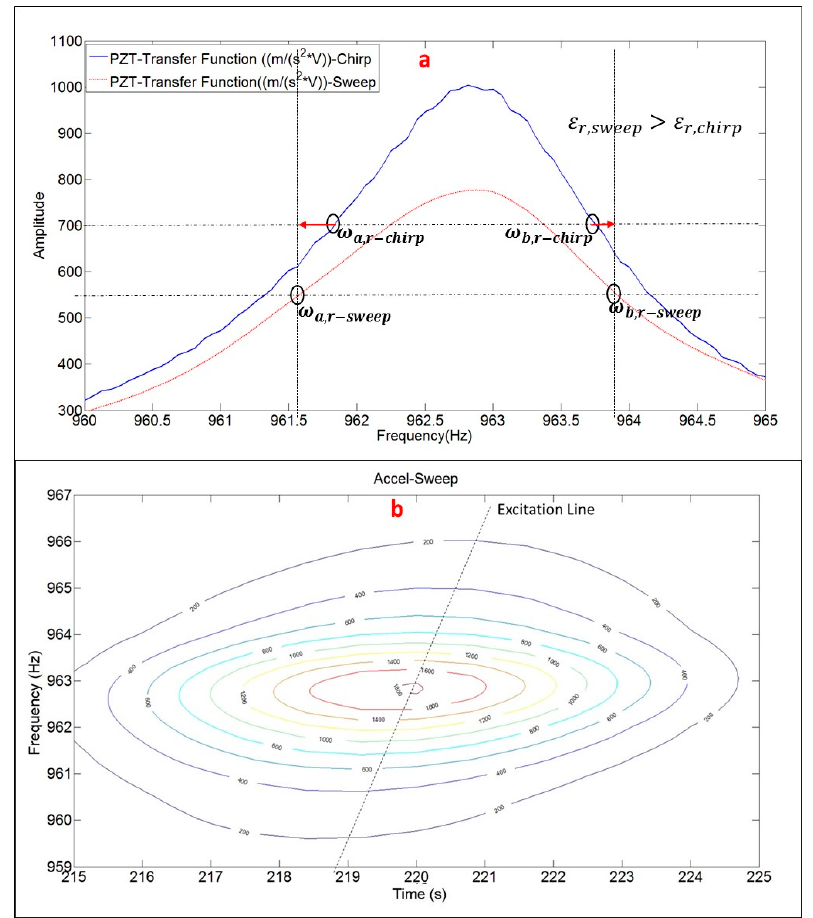
Figure 10 . ( a ) Comparison PZT-Transfer function within Sweep and Chirp; and ( b ) detailed Time–Frequency representation of the peak hold method analysis for the sweep excitation.